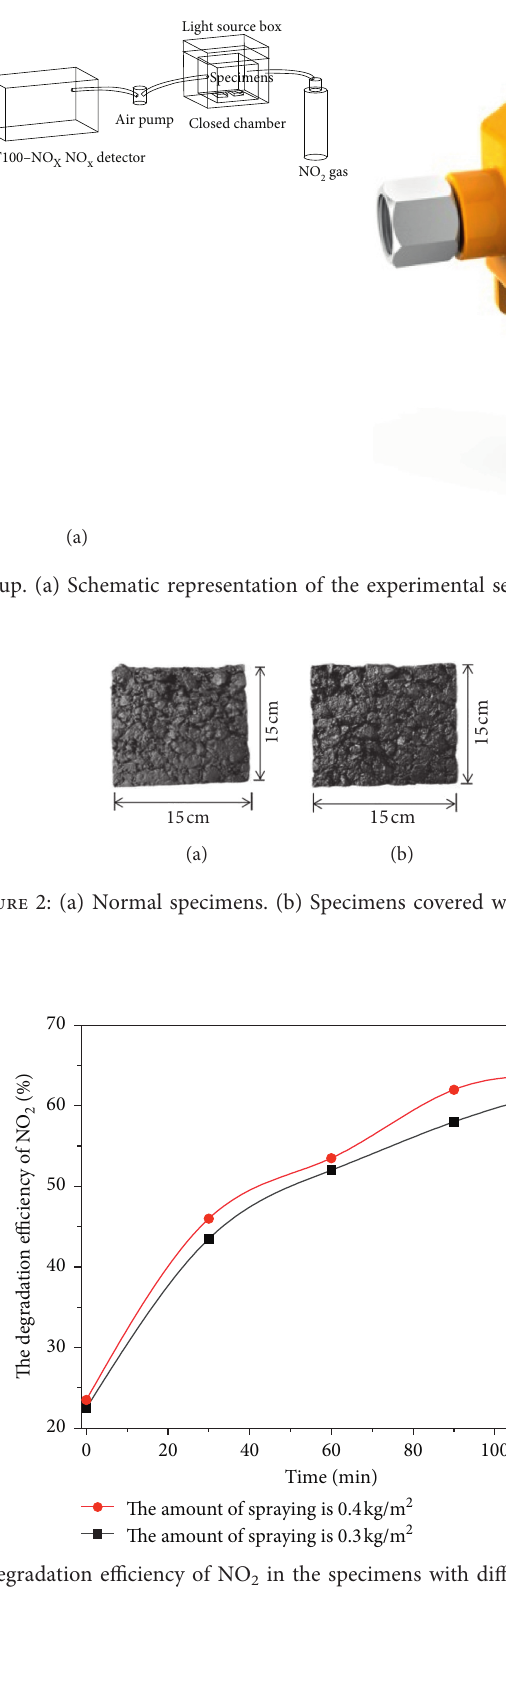
Figure 3: Degradation efficiency of NO 2 in the specimens with different amounts of TiO 2